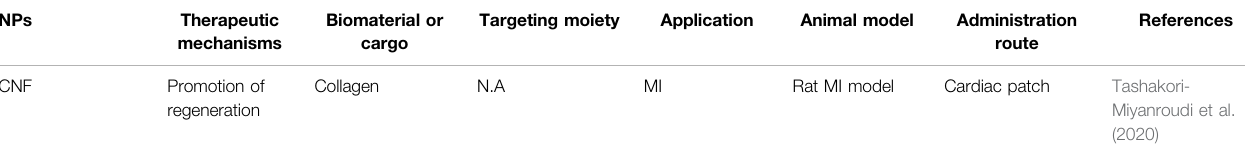
TABLE 1 | ( Continued ) Summary of the Nanomedicines used for ASCVD treatment targeting the mechanisms of ASCVD